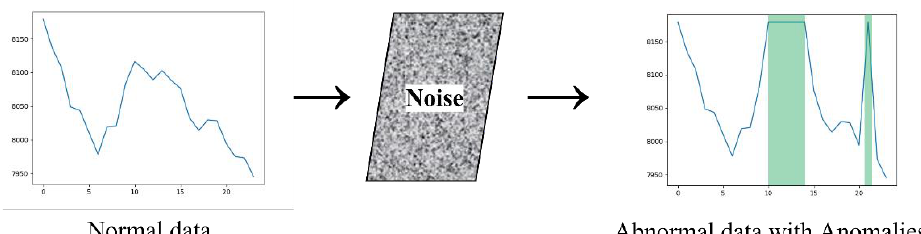
Figure 7. Process of injecting anomalies in data.